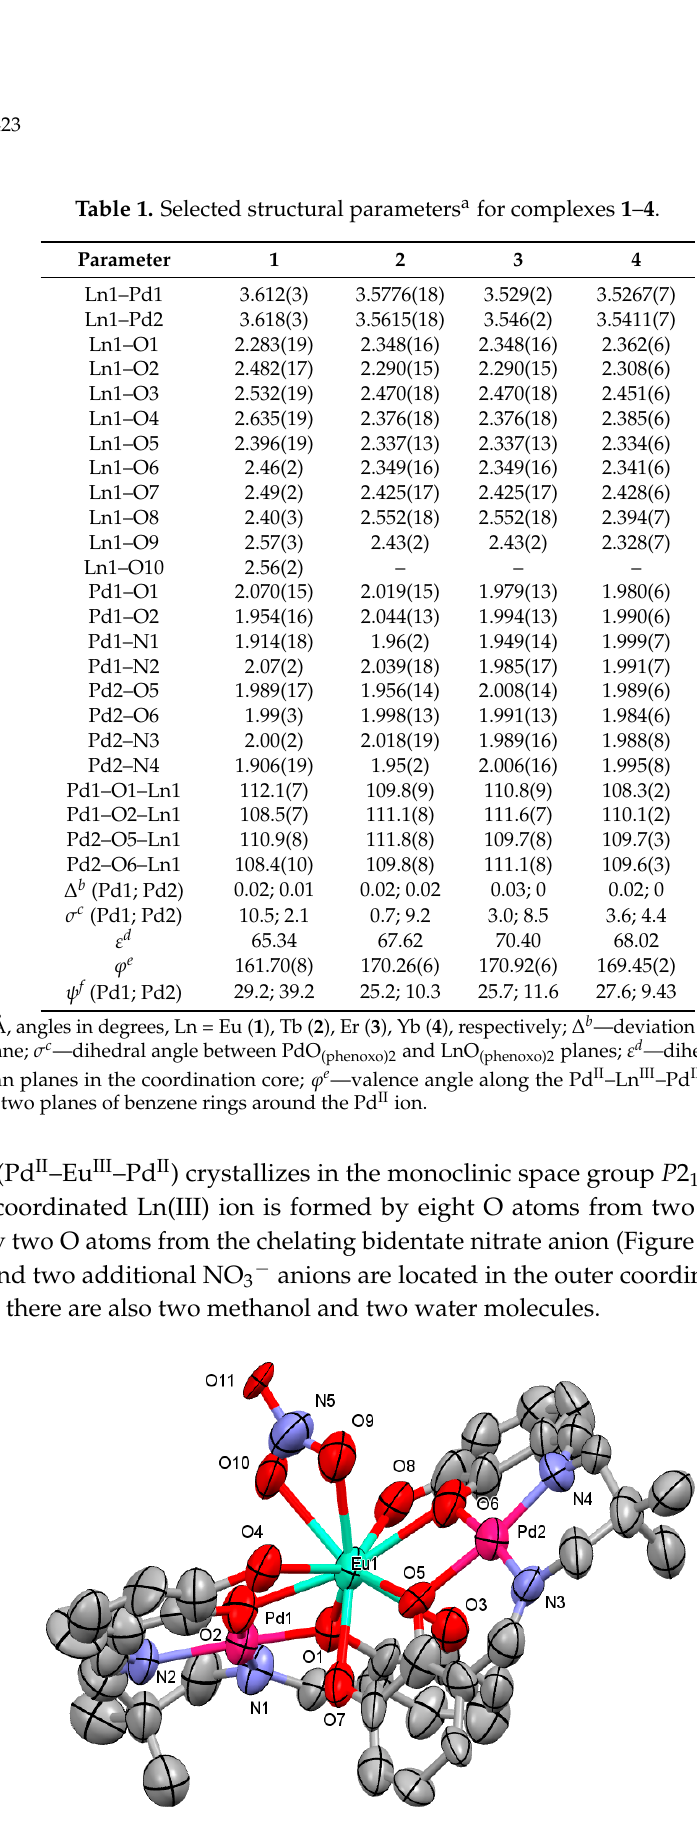
Figure 1. Molecular structure of the coordination unit in 1 .